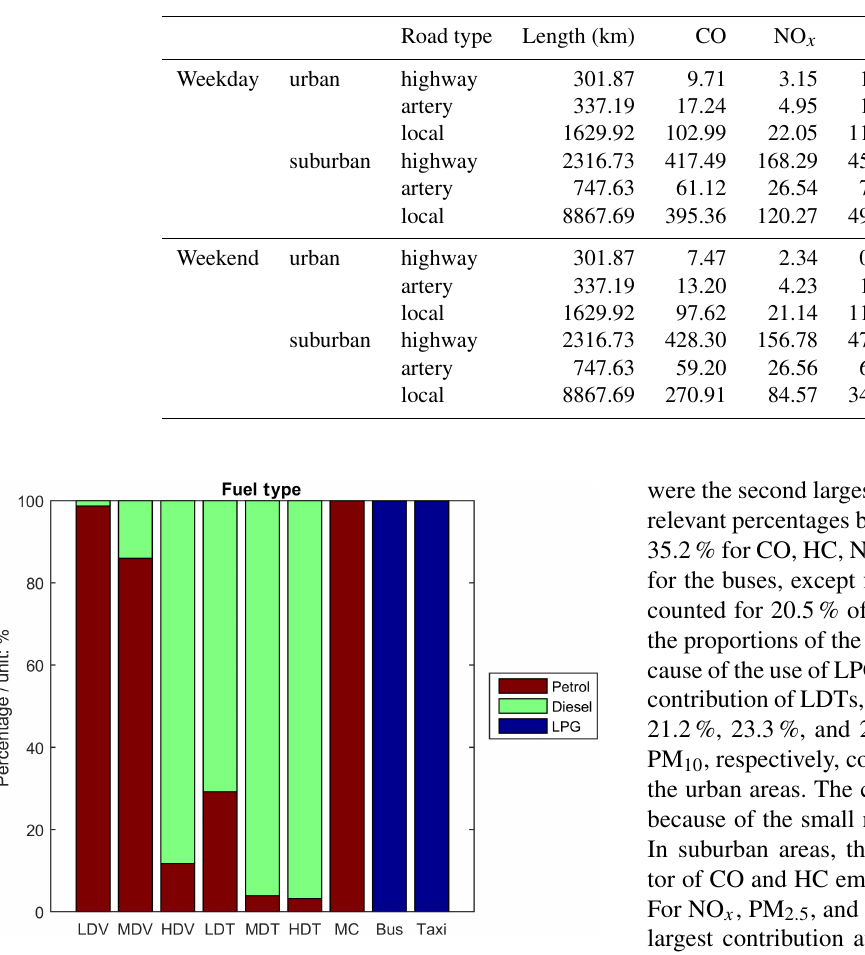
Figure 6. Fuel type percentage of each vehicle